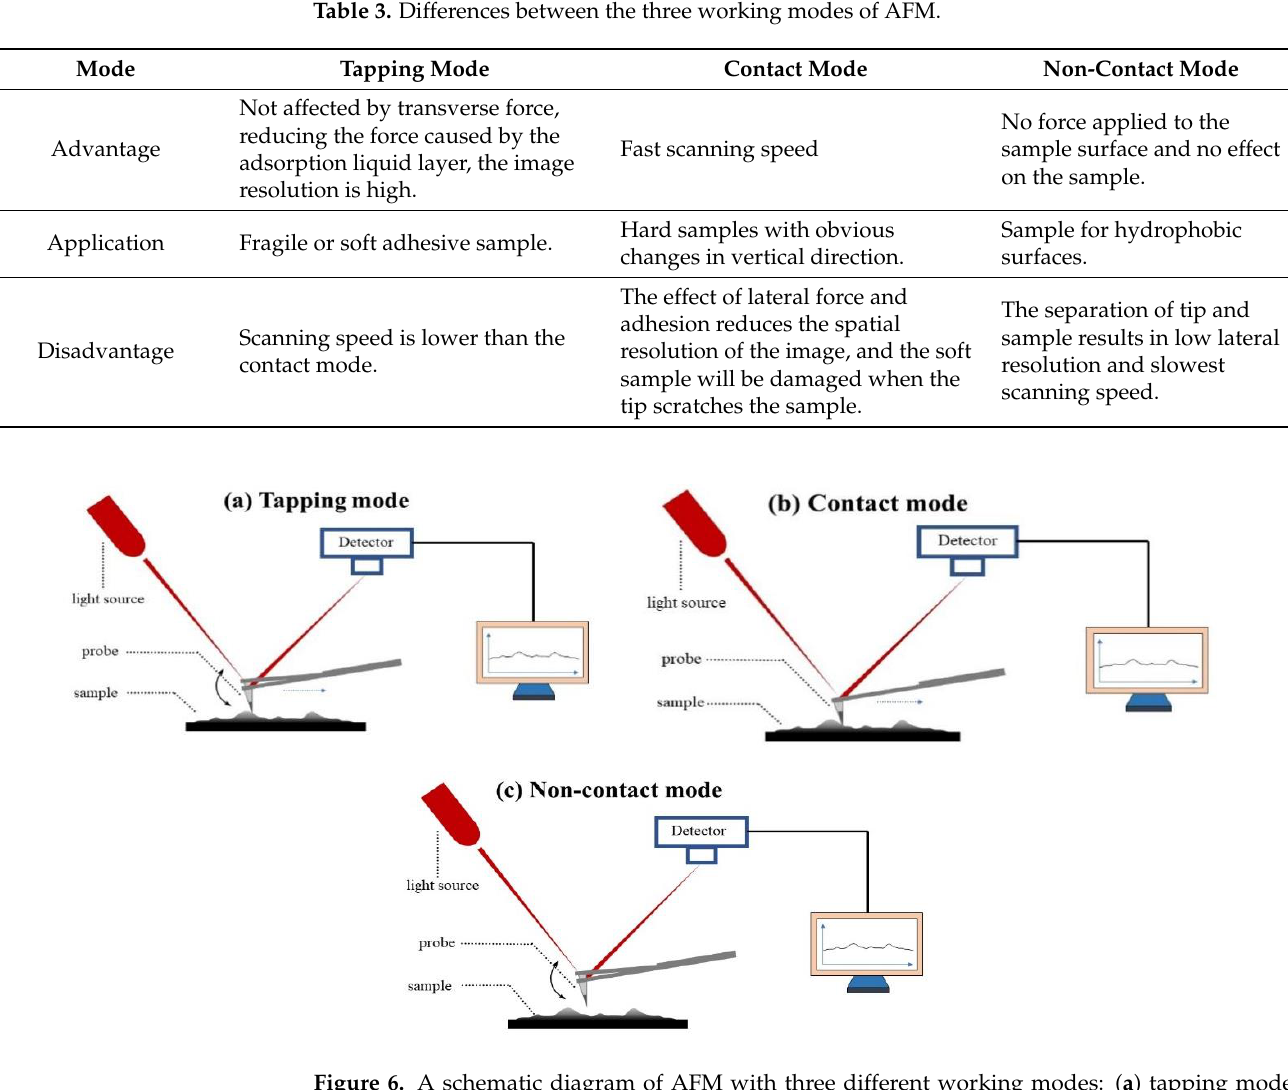
Table 3. Differences between the three working modes of AFM.